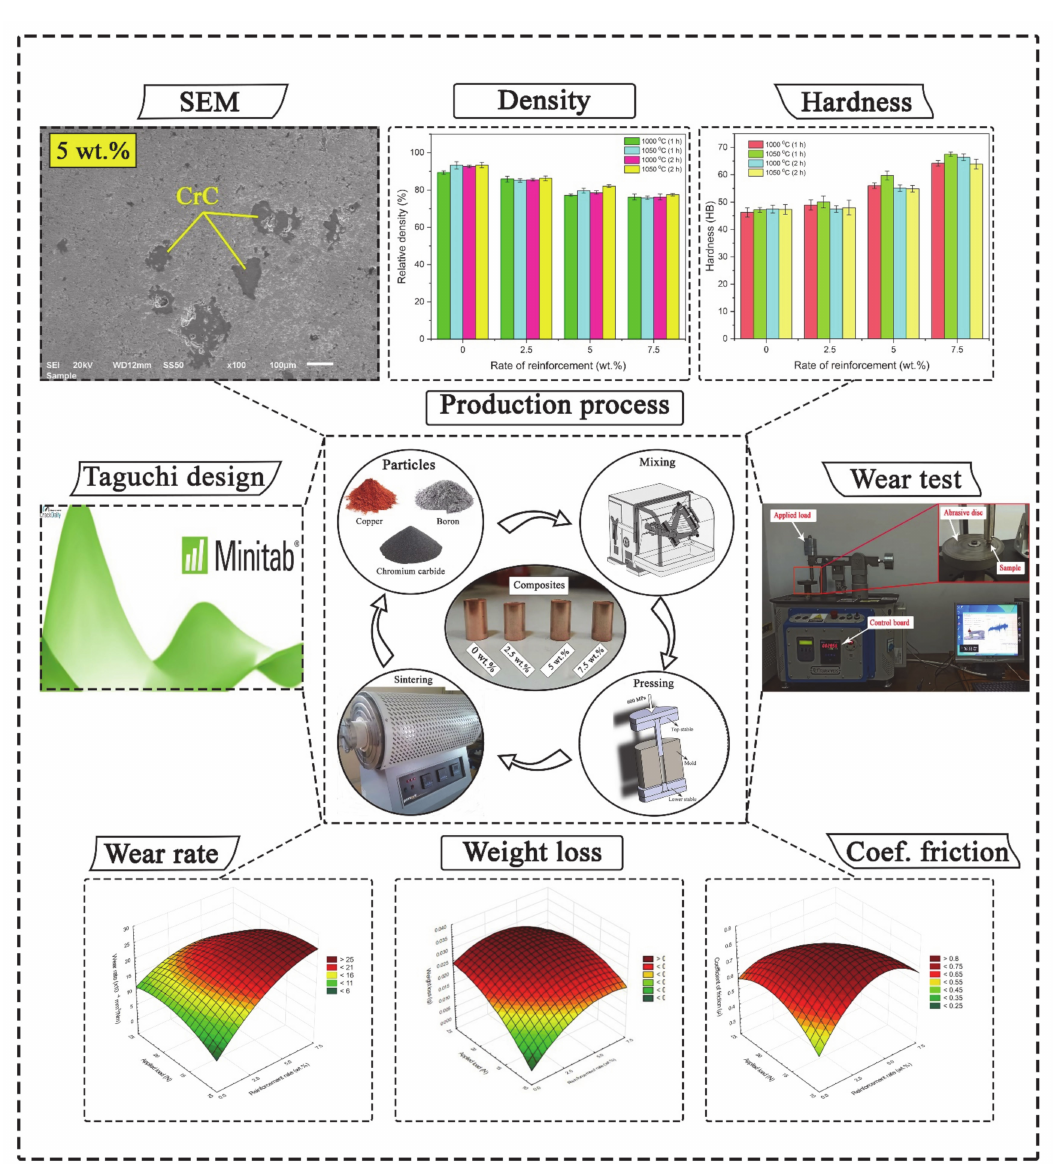
Figure 2. The experimental scheme the experimental